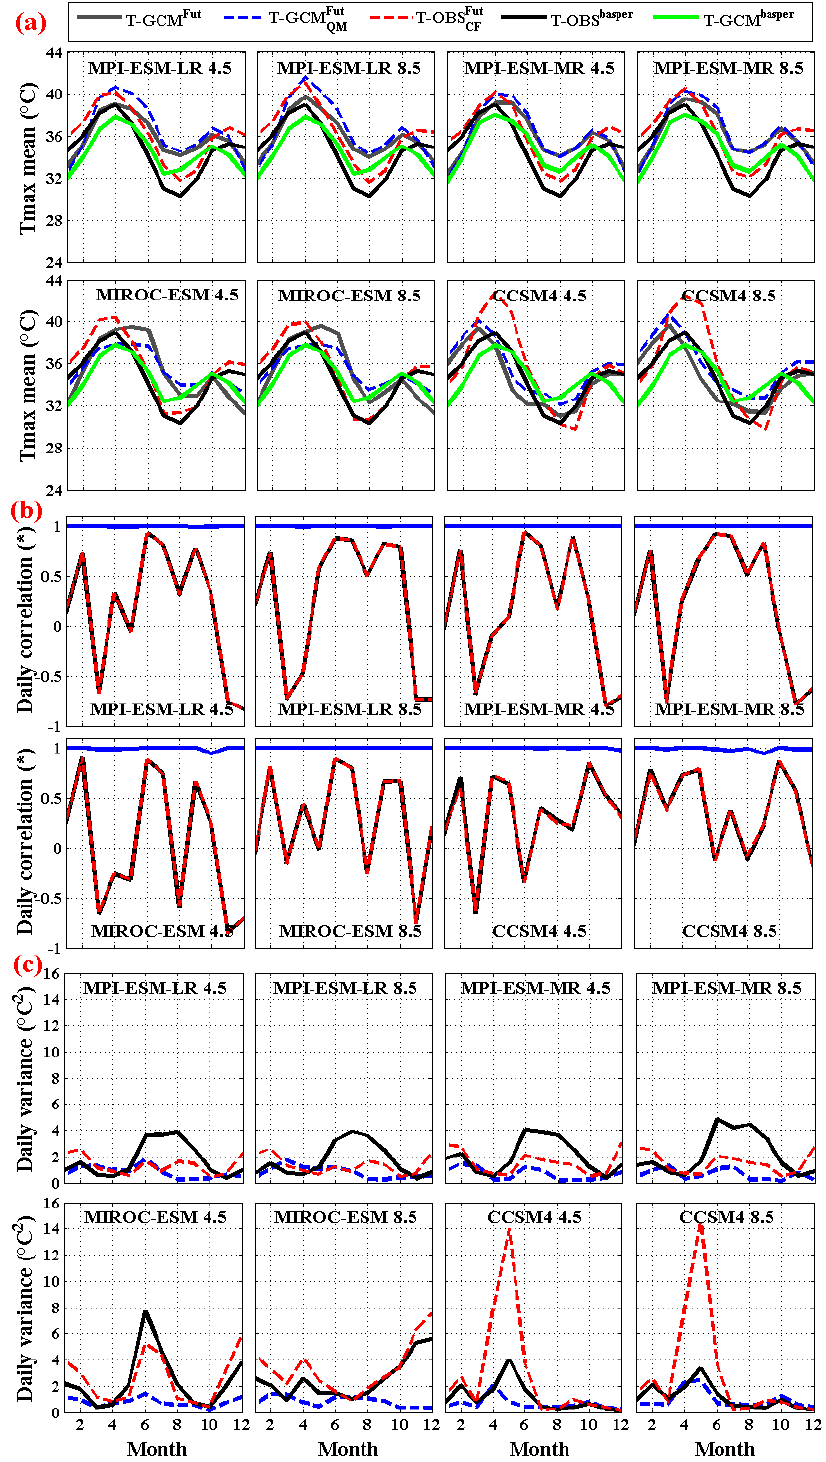
Figure 9. The MPI-ESM-LR, MPI-ESM-MR, MIROC-ESM, and CCSM4 model results over the DRB. Comparison at monthly level between the statistical properties of the GCM output ( T max ) data and its downscaled data using the CF ( P − OBS fut approaches. For more explanation, the observed data for the baseline period ( P − OBS basper ) are also shown.